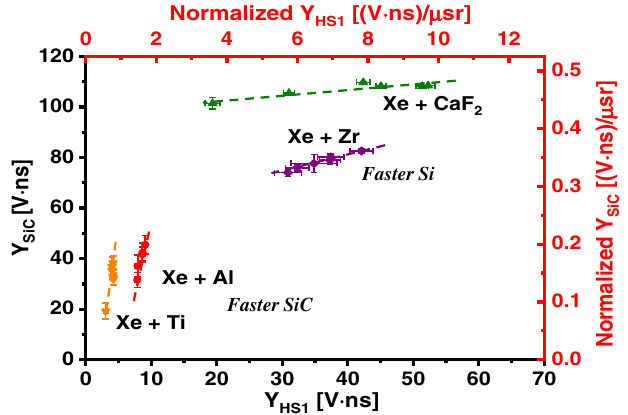
FIG. 5. Linearity test for Xe plasma emission. The plots report the SiC detector signal as a function of the HS1 detector in terms of time-integrated voltage and in terms of the normalized solid